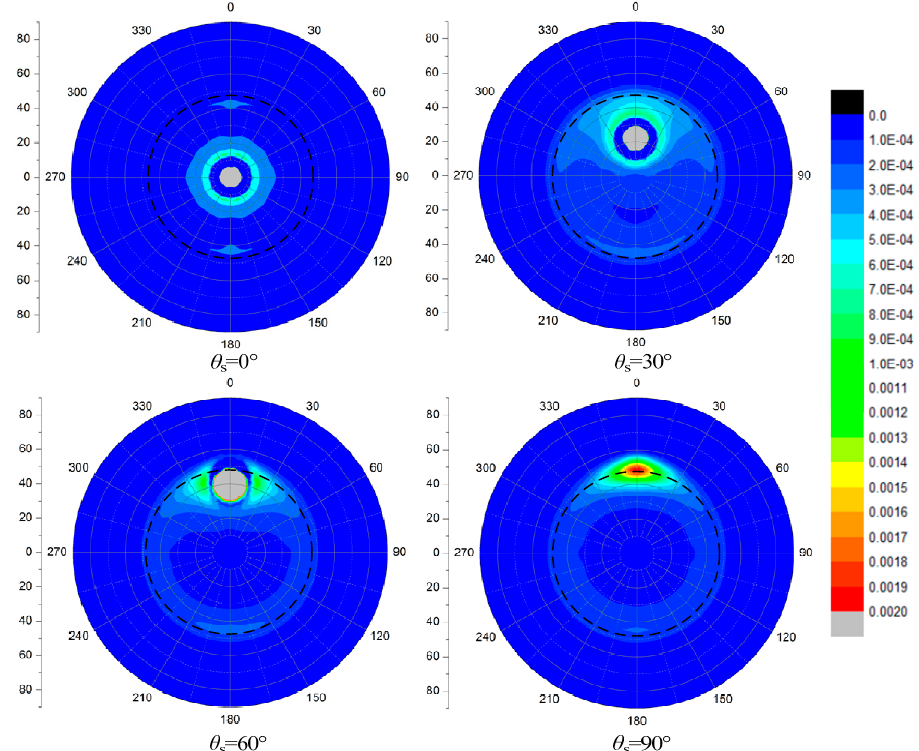
Figure 9. The intensity distributions of transmitted light under a wavy water surface with different SZAs, where wind speed is 5m/s, wind direction is 0°